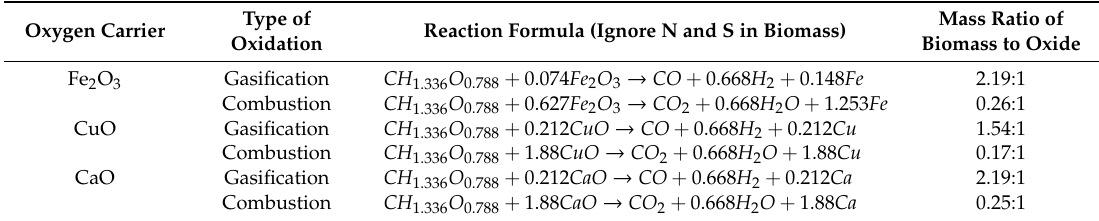
Table 1. Theoretical mass ratios of biomass to the oxygen carriers of Fe 2 O 3 , CuO and CaO for complete oxidation and ideal